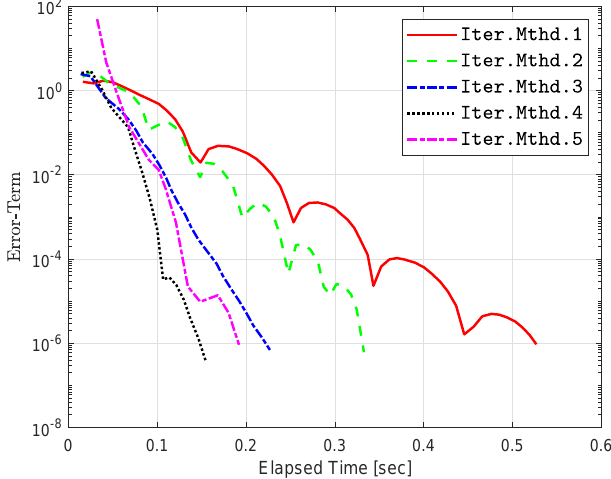
Figure 14. All techniques are computationally examined while s 0 = ( − 1,6,3, − 4,4 ) T .